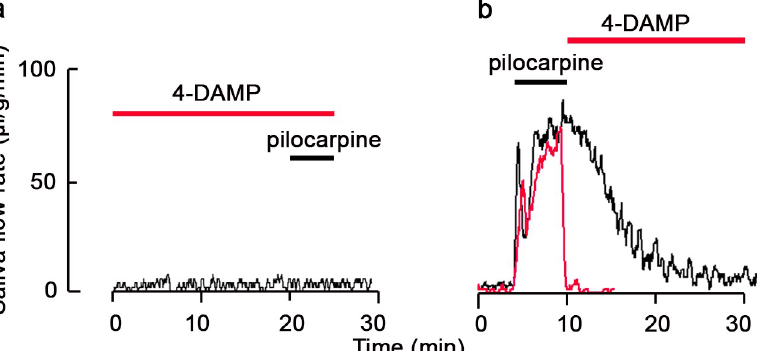
Fig 6. Effect of the muscarinic antagonist 4-DAMP on pilocarpine-induced residual secretion of salivary fluid in perfused submandibular glands of rats. (a) Effect of 4-DAMP on pilocarpine-induced salivary fluid secretion. After pre-incubation with 100 μ M 4-DAMP, submandibular glands were stimulated with 100 μ M pilocarpine. (b) After stimulation with 100 μ M pilocarpine, submandibular glands were perfused with 100 μ M 4-DAMP with pilocarpine. Periods of 4-DAMP treatment and pilocarpine stimulation are depicted as red and black bars, respectively. Results are representative of three independent